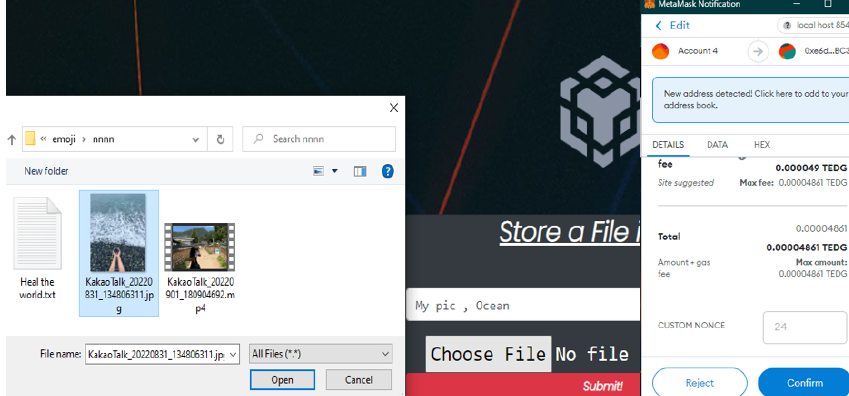
Figure 17. Choosing a file and confirming Metamask transaction.